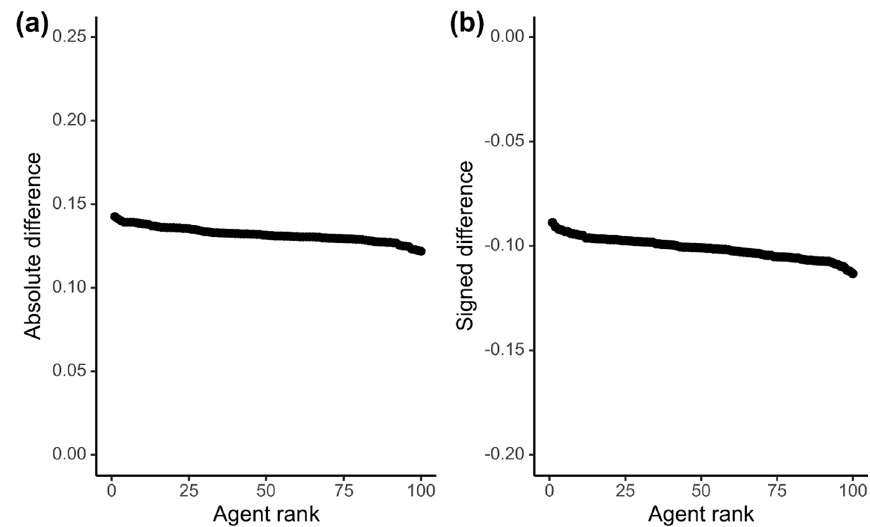
Fig. 4 Within-agents effect of bot across the two simulations. (a) The absolute difference between each agent’s opinion at time t 300 between the two simulation conditions (bot vs. no bot). This analysis = measures the bot’s total impact on the opinions of the same agents in the network. (b) The signed difference between each agent’s opinion at time t 300 between the two simulation conditions (bot vs. no bot). This = analysis shows the direction of the social influence of the bot on individuals’